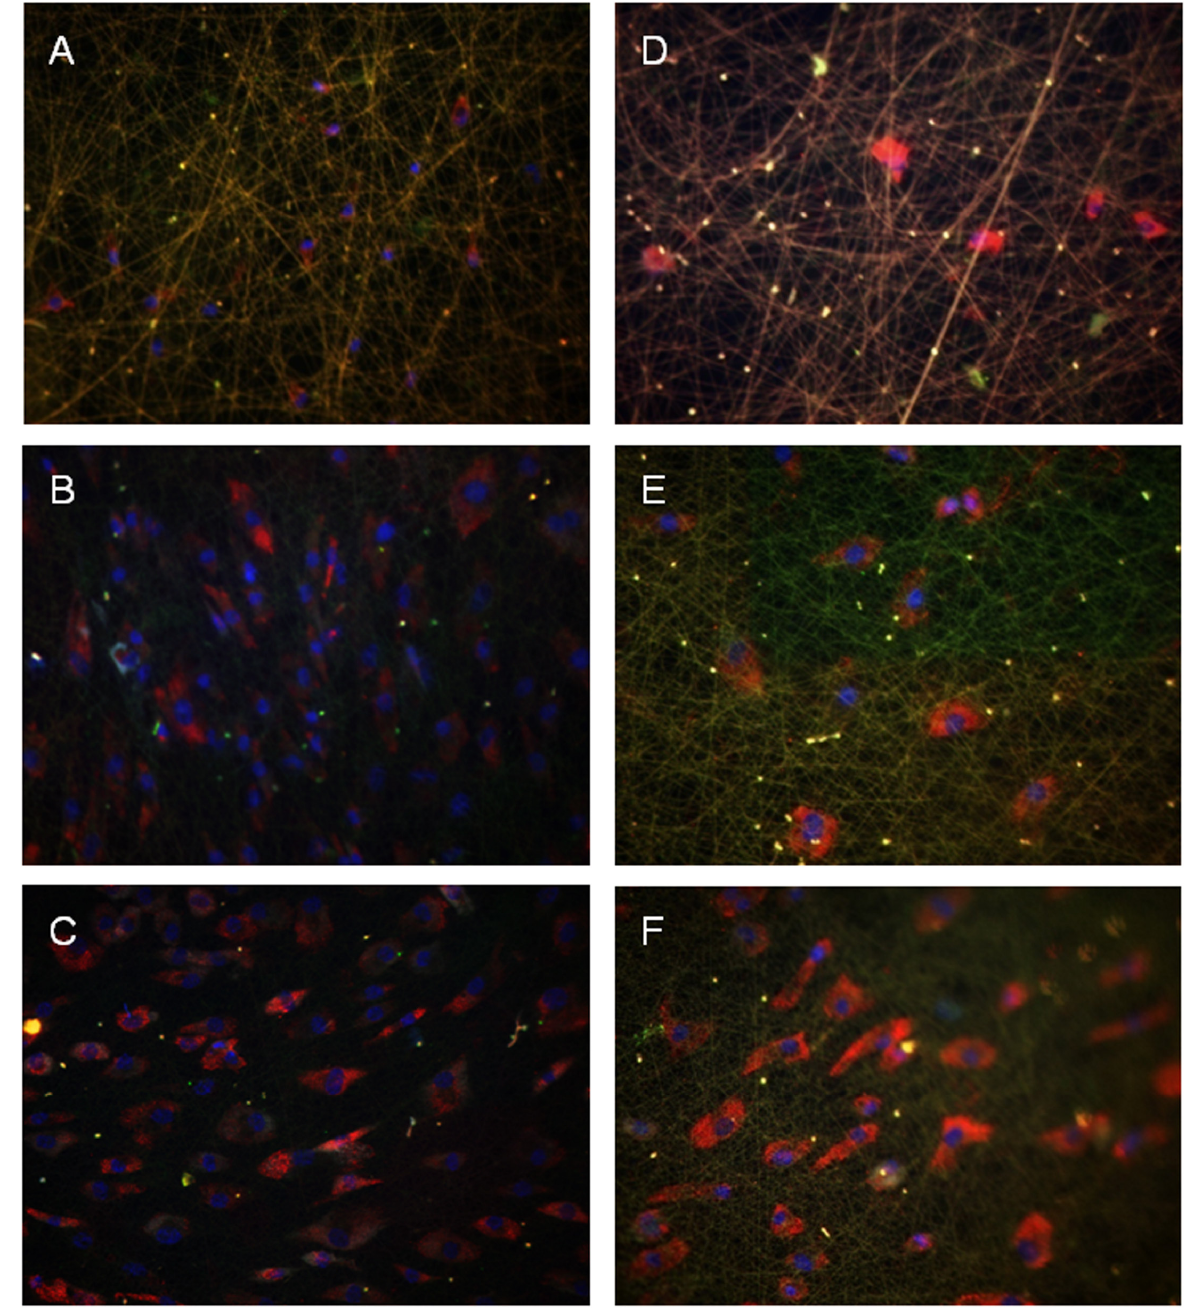
FIGURE 4 . Influence of PLLA-COLI blending on growth and differentiation of hMSC. Immunofluorescence microphotographs of OC (green) and COLI (red) deposition of hMSC, cultured under growth conditions on PLLA-COLI blend nanofibers of different composition and fixation: PLLA:COLI 1:2 (A), PLLA:COLI 2:1 (B), PLLA:COLI 4:1 (C), PLLA:COLI 1:2 linked (D), PLLA:COLI 2:1 linked (E), PLLA:COLI 4:1 linked